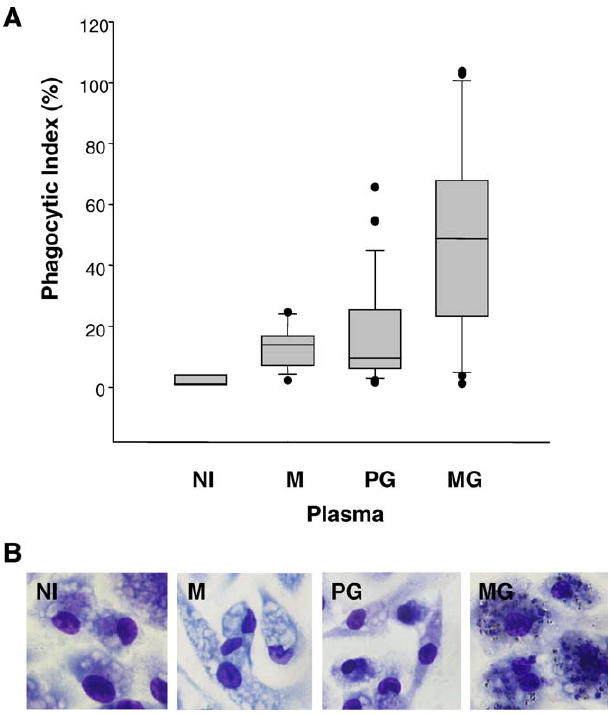
Figure 1. Plasma Opsonizing activity of CSA-Binding Parasitized Erythrocytes Is Sex-Specific and Parity-Dependent (A) Box (median and IQR) and whisker (range) plot showing phagocytic index of CSA-binding (CS2) PEs opsonized with plasma from non- immunes (NI) ( n ¼ 3), malaria-exposed males (M) ( n ¼ 14), malaria- exposed PG ( n ¼ 21), or malaria-exposed MG ( n ¼ 16) donors. Statistical significance was assessed by Mann-Whitney rank sum test. *M versus MG p ¼ 0.0015; PG versus MG p ¼ 0.0031. (B) Photomicrographs show examples of murine macrophage internal- ization of CSA-binding (CS2) PEs opsonized with plasma from individual donors.